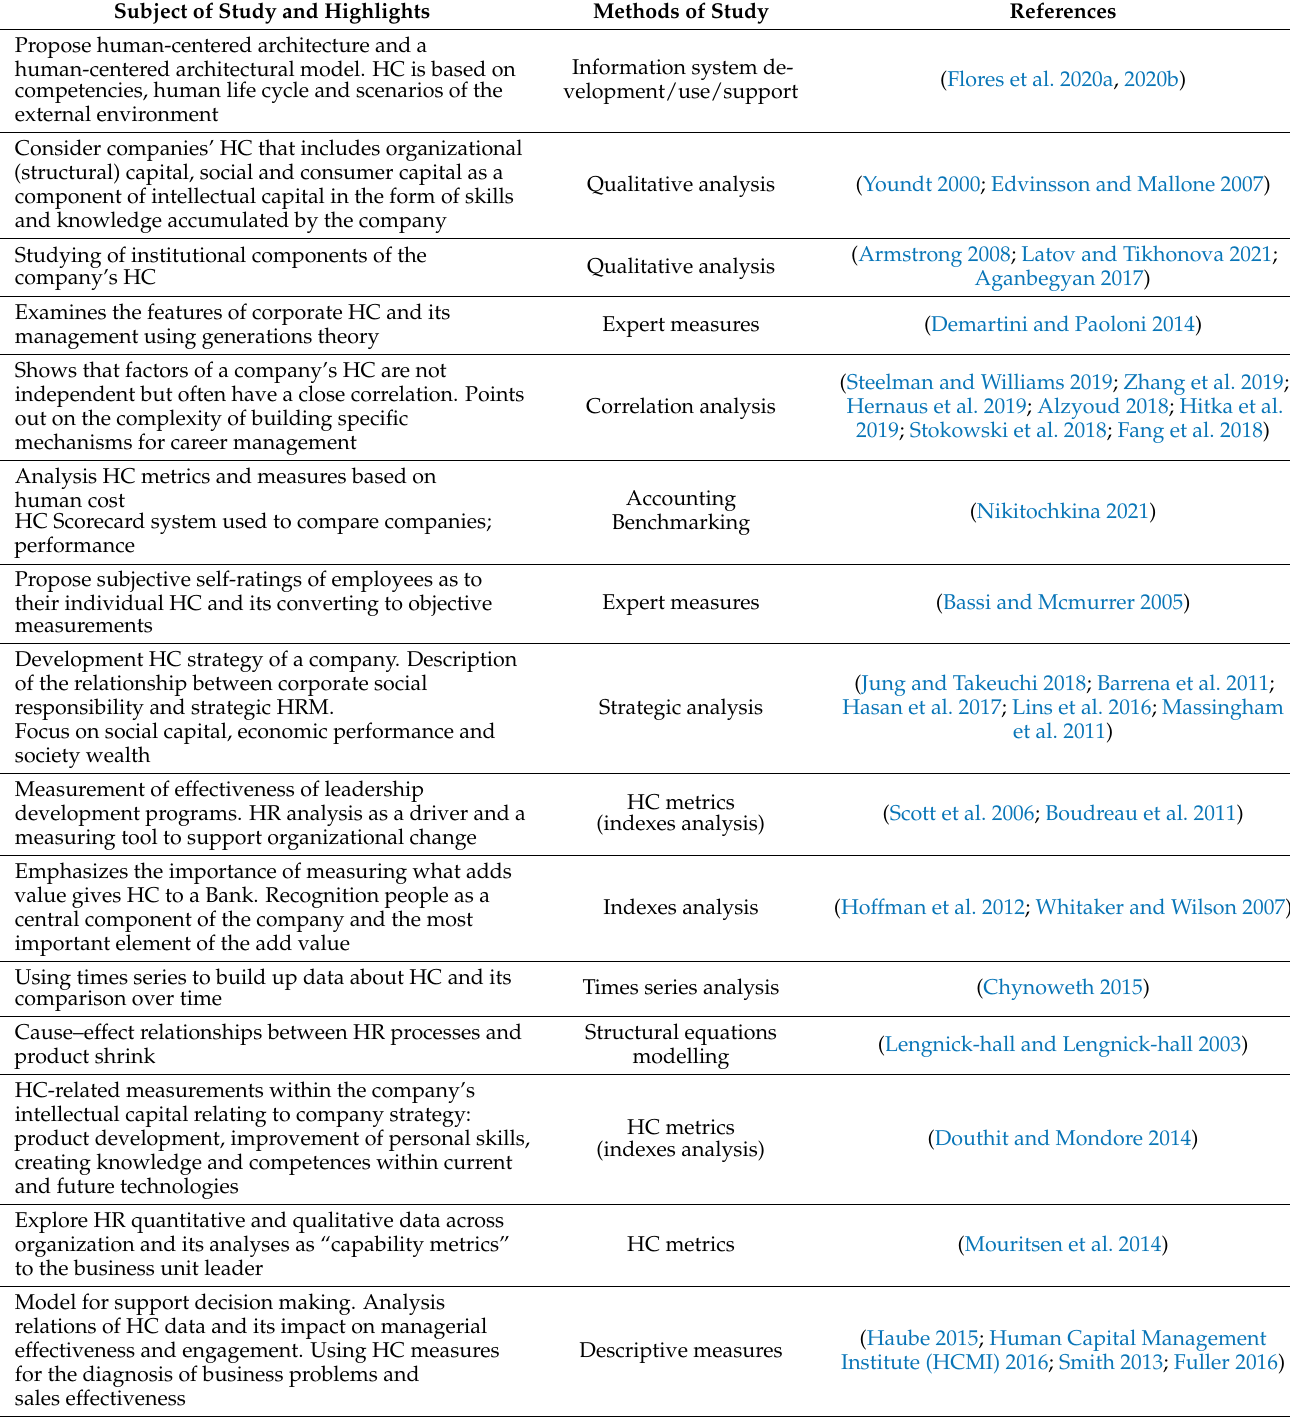
Table 2. Corporate HC related